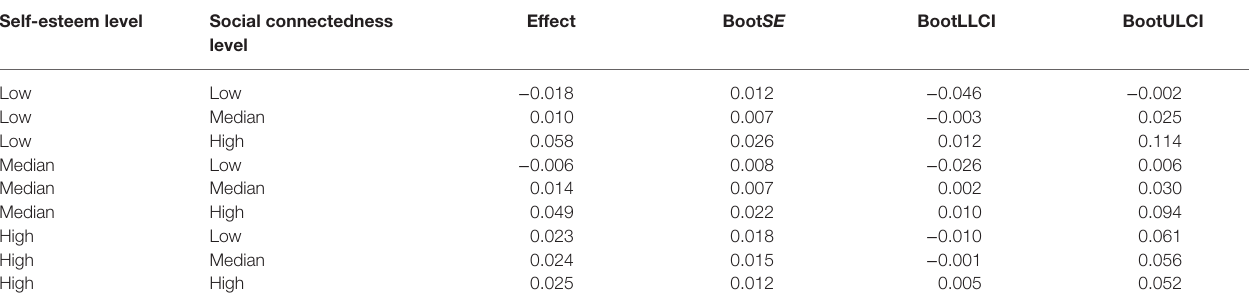
TABLE 3 | Conditional indirect effects of social VR involvement on well-being via depression. Self-esteem level